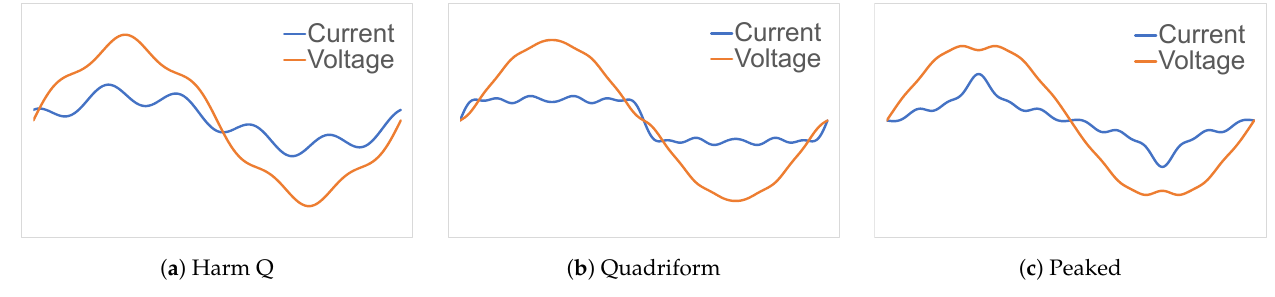
Figure 1. Distorted tests waveforms.